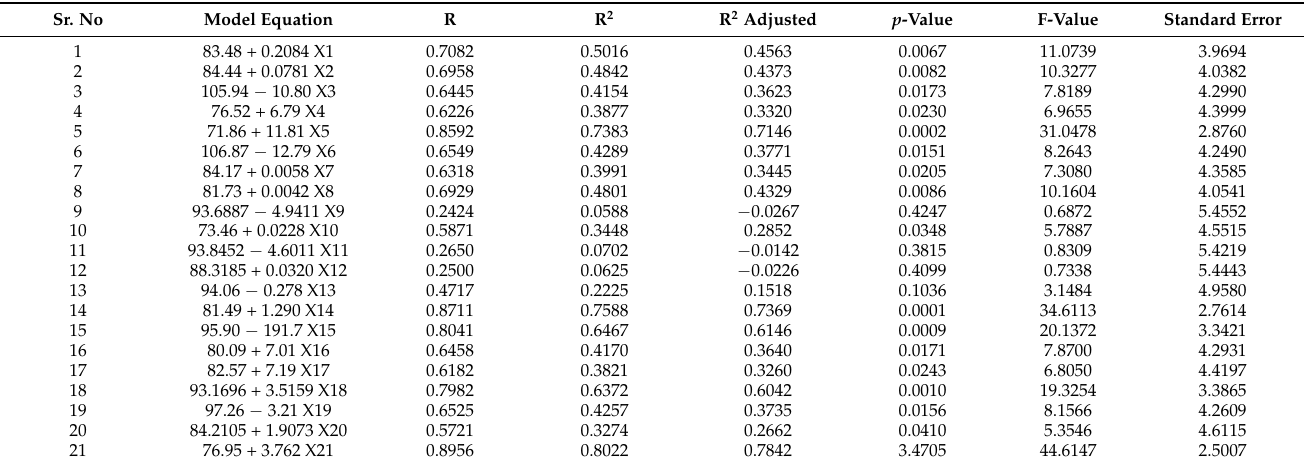
Table 1. Linear regression analysis to show the relationship between % sorption onto Aerva javanica and metal ionic